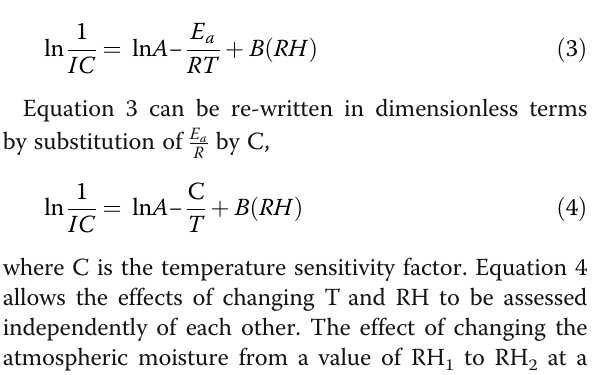
0.937 and 0.954 for R 2 mean that 6.3 % (API 1) and 4.6 %